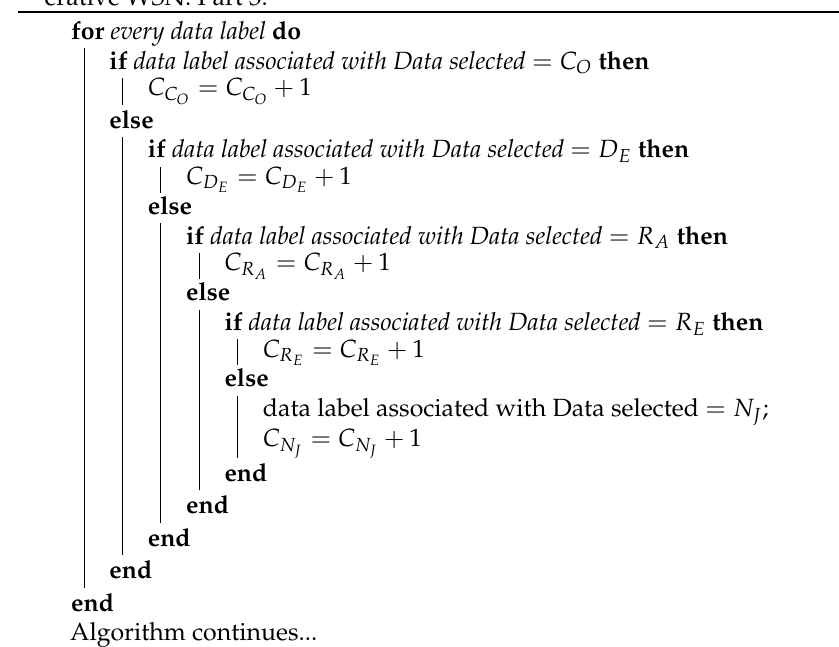
Algorithm 3: Proposed jamming detection algorithm for collaborative and coop- erative WSN. Part